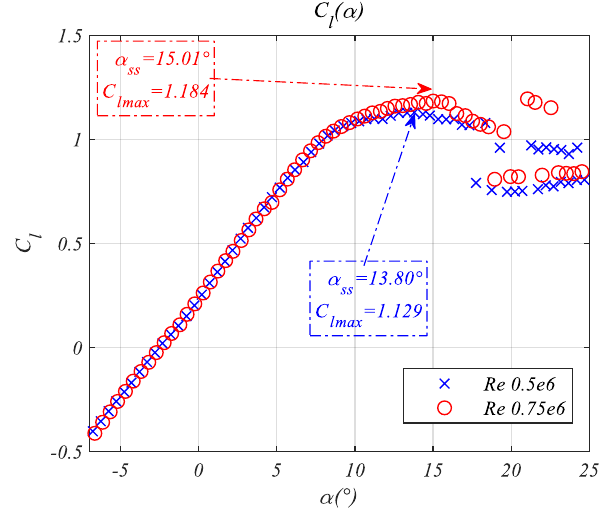
Figure 6. Lift coefficient versus angle of attack for Re = 0.5 × 10 6 and 0.75 × 10 6 . Based on oil flow visualization, it is interesting to notice in Figure 7 that increasing the angle of attack from 11° to 17°, where the lift peak was met, the flow separation line (which deviated from a straight pattern indicating three dimensional flow effects) travelled progressively upstream, covering a distance of 0.2 c. More particularly, at the wing mid span, this line passed from x/c = 0.5 at 11° and reached x/c = 0.3 at 17°. In the latter figure, a straight red line has been drawn at a distance x = 0.4 c from the leading edge. A similar picture was given by the flow visualization based on tufts (see Figure 8) which upstream of the flow separation line were straight and parallel to the free stream whereas downstream of it they were oriented far from the midspan towards the wing ends due to the three dimensional separated flow region. In the same figure (Figure 8), a straight red line is drawn parallel to the leading edge at x = 0.4 c as well as a curved green line which is the separation line identical with that of Figure 7b. It is reminded that Figures 7 and 8 refer to Re = 0.5 × 10 6 .